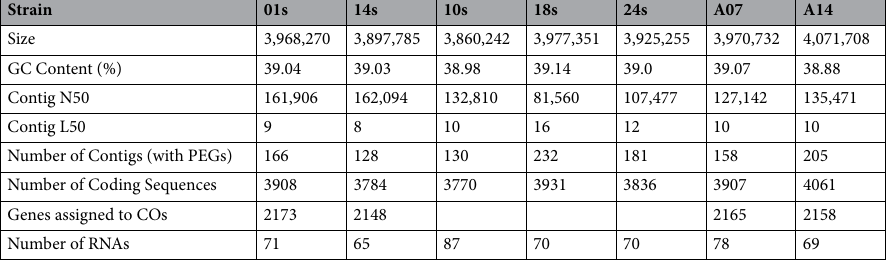
Table 2. General features of A. baumannii strains genomes.